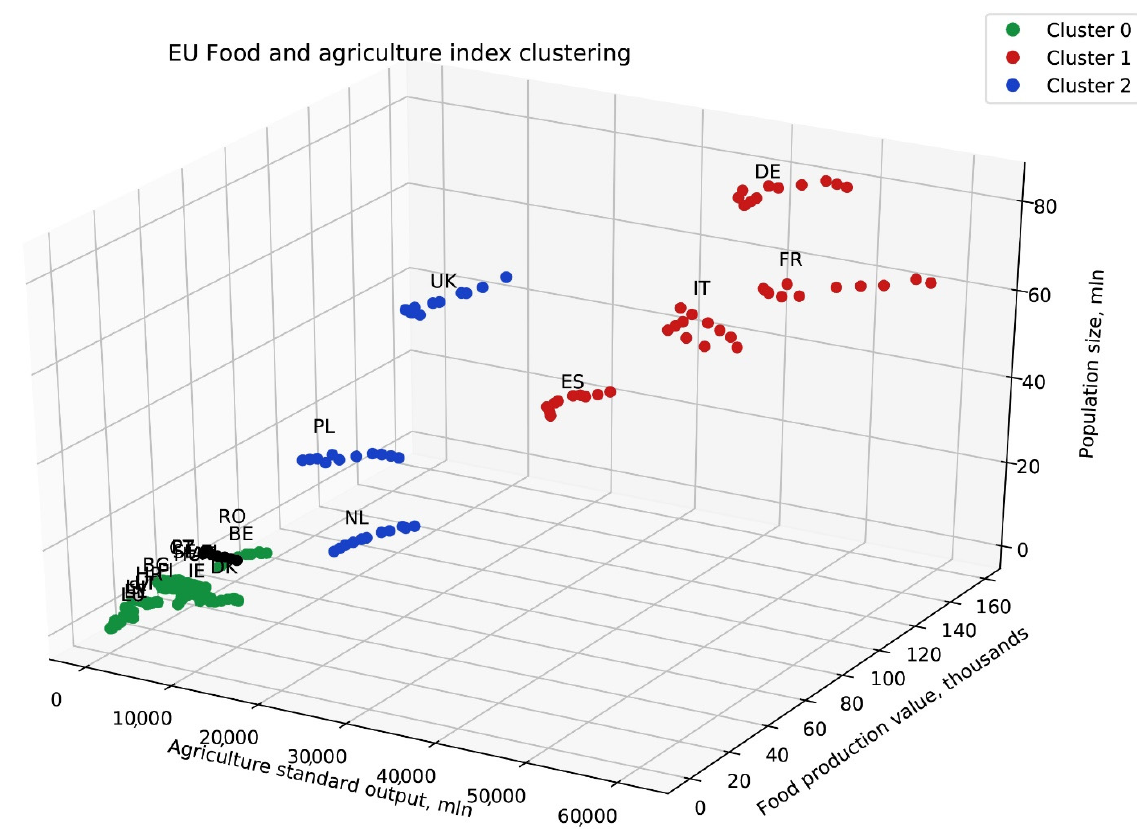
Figure 7. EU food and agriculture index clustering, created by authors.